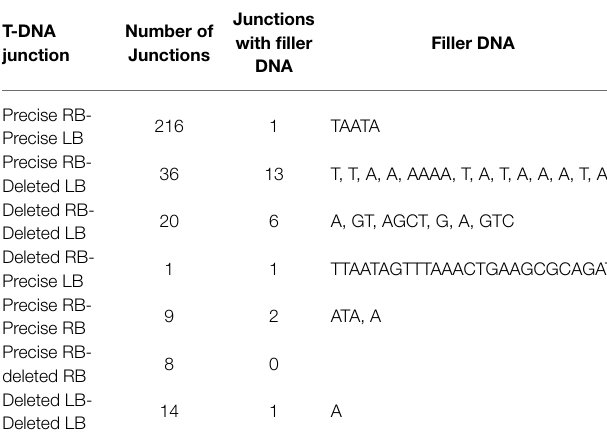
TABLE 3 | Filler DNA from unknown source at T-DNA junctions. T-DNA